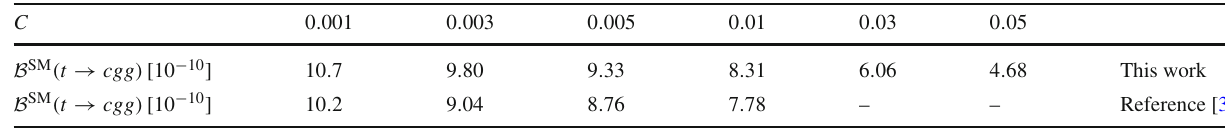
Table 3 The cutoff dependence of the branching ratio of t → cgg decay within the SM, as well as the comparison with that obtained in Ref. [39]. Note that the MS running masses of both the top and charm